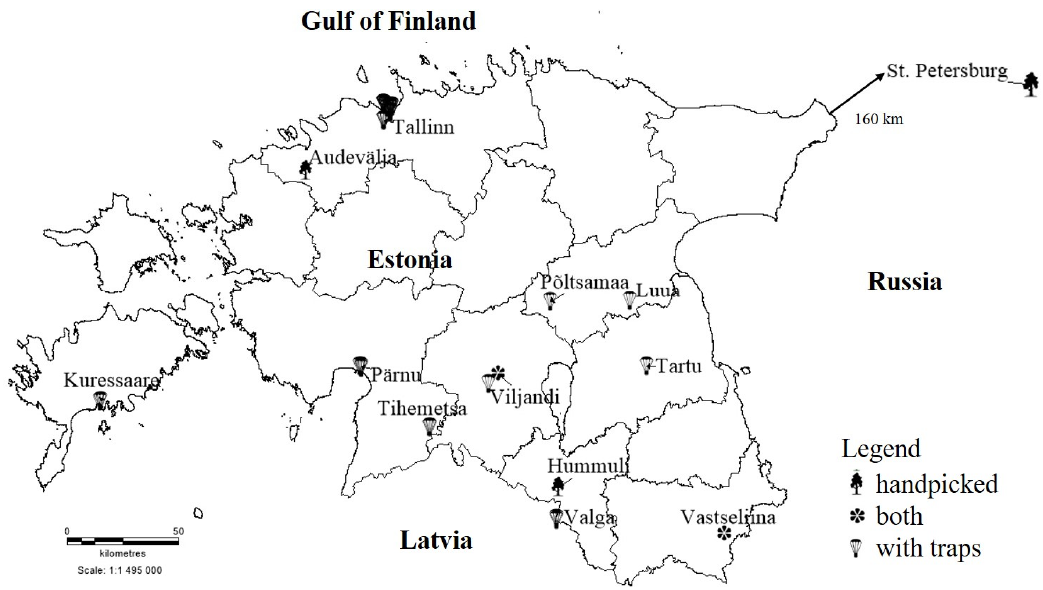
Figure 1. Study sites in Estonia and St. Petersburg, Russia. Bark beetles were handpicked and collected with traps or with both possibilities from the same tree.